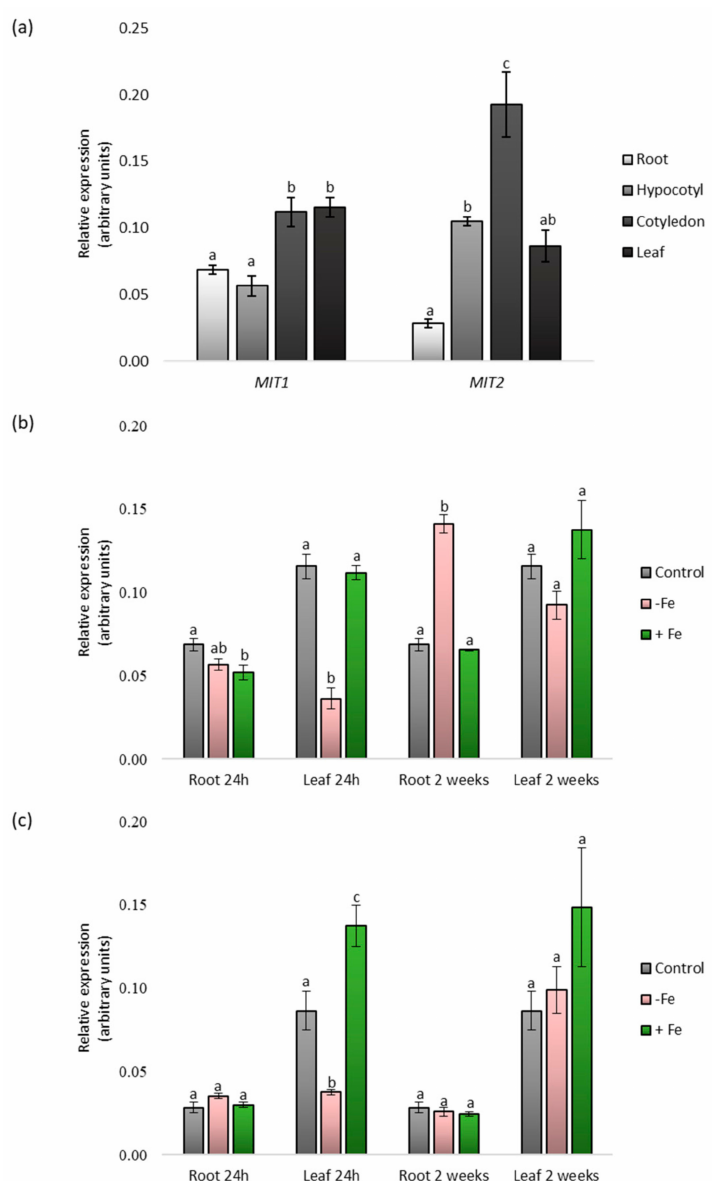
Figure 2. CsMIT1 and CsMIT2 gene expression in different organs of cucumber plants grown under various iron treatments. ( a ) The expression of CsMIT1 and CsMIT2 in the vegetative organs of two-week-old cucumber seedlings grown in control medium. ( b ) The expression of CsMIT1 in the roots and leaves of two-week-old cucumber seedlings grown in control medium or subjected to Fe deficiency (-Fe) and Fe excess (+Fe) for 24 h or two weeks. ( c ) The expression of CsMIT2 in the roots and leaves of two-week-old cucumber seedlings grown in control medium or subjected to Fe deficiency (-Fe) and Fe excess (+Fe) for 24 h or two weeks. For real-time analysis, expression of individual genes was calculated relative to the reference gene CsCACS according to the ∆∆ CT method. Results shown are the means of three biological replicates; error bars represent standard error (+/-SE). Different letters represent statistically significant differences ( p < 0.05; ANOVA with Tukey’s